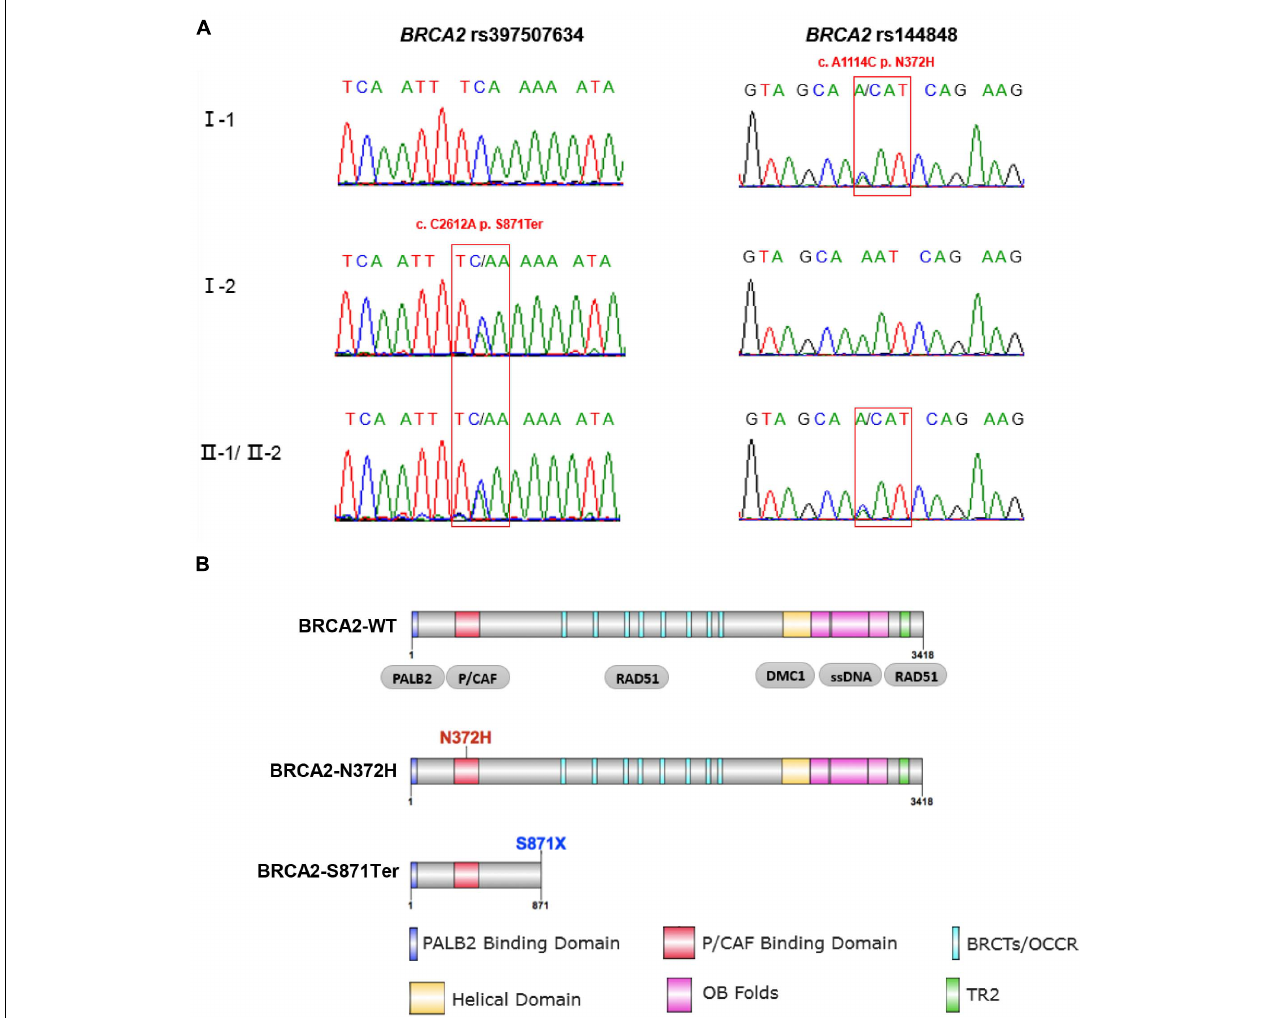
FIGURE 3 | Sanger sequencing validation and functional domains of full-length and mutant BRCA2 protein. (A) Sanger sequencing confirmed the mutations of BRCA2 . The two patients (II-1 and II-2) carried both of these two variants. The father carried BRCA2-N372H, while the mother carried BRCA2-S871Ter. (B) The full-length BRCA2 protein harbors six functional domains, including PALB2 binding domain, P/CAF binding domain, BRCTs repeat region, Helical domain, OB folds, and TR2 domain. BRCA2-N372H mutant is in the P/CAF binding domain; while the BRCA2-S871Ter variant results in premature truncation at the 871st amino acid of BRCA2 protein, which only includes the PALB2 and P/CAF binding